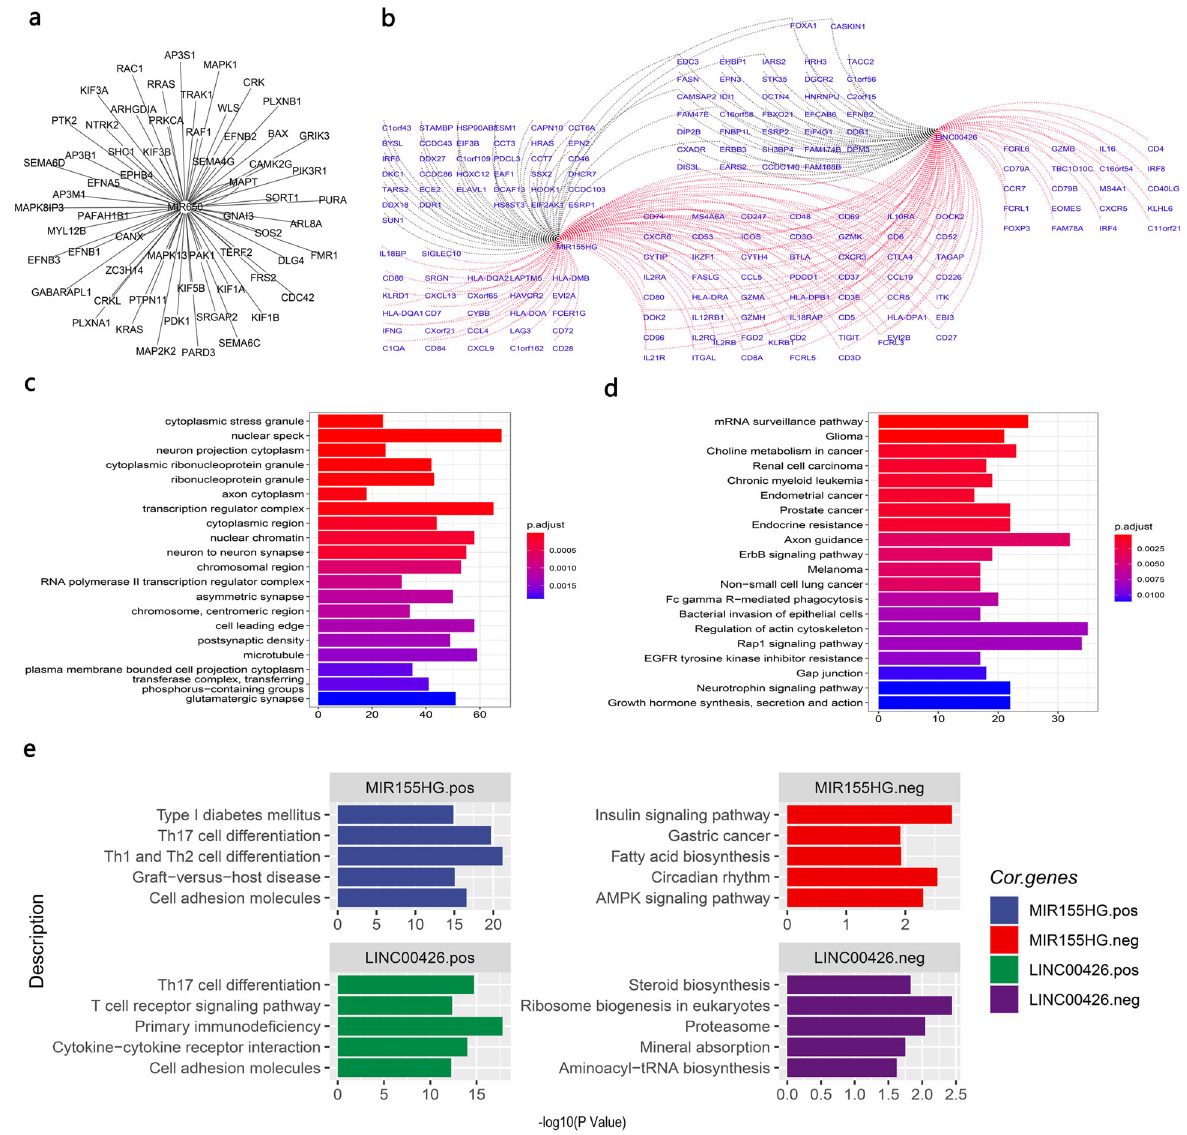
Fig. 4 Noncoding RNA patterns of in fl amed and nonin fl amed TMEs. a Potential targets of miR-650 (only genes annotated by neuronal pathways in c and d were visualized, and all potential targets are shown in Supplementary Data 1). b Coexpression network of identi fi ed lncRNAs. The red line represents a positive correlation, and the black line represents a negative correlation. c Gene ontology (GO) functional analysis of potential miRNA targets. d Functional analysis of miRNA targets with the Kyoto Encyclopedia of Genes and Genomes (KEGG) database. e Functional analysis of lncRNA coexpressed genes was performed with the Kyoto Encyclopedia of Genes and Genomes (KEGG) database. The left panel shows the functions of lncRNA positively correlated genes. The right panel shows the functions of lncRNA negatively correlated